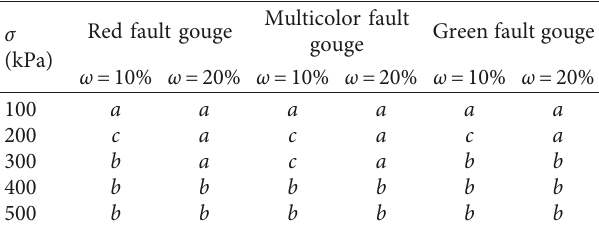
Figure 10: Shear surfaces of different failure modes. (a) Peeling failure. (b) Sliding failure. (c) Grooved failure. Table 3: Statistics of failure modes of the shear